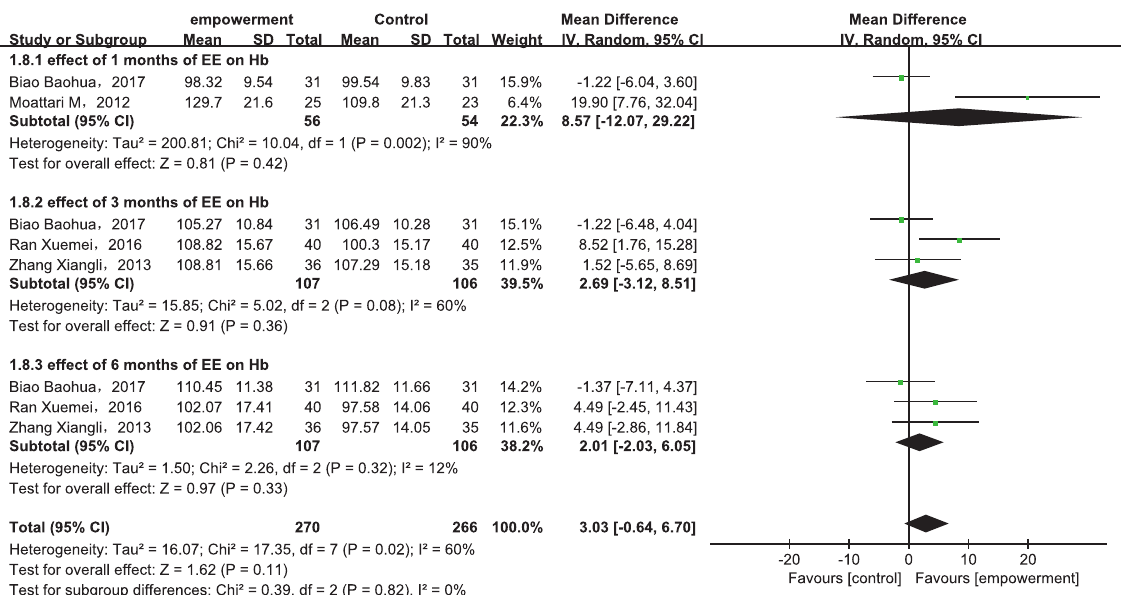
Figure 6. Comparison of hemoglobin between empowerment education intervention group and traditional education group.